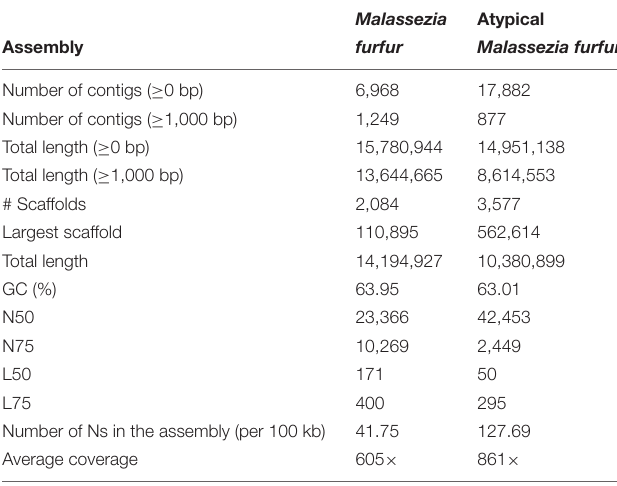
TABLE 1 | Assembly statistics calculated by QUAST (Gurevich et al., 2013) and BEDtools (Quinlan and Hall,